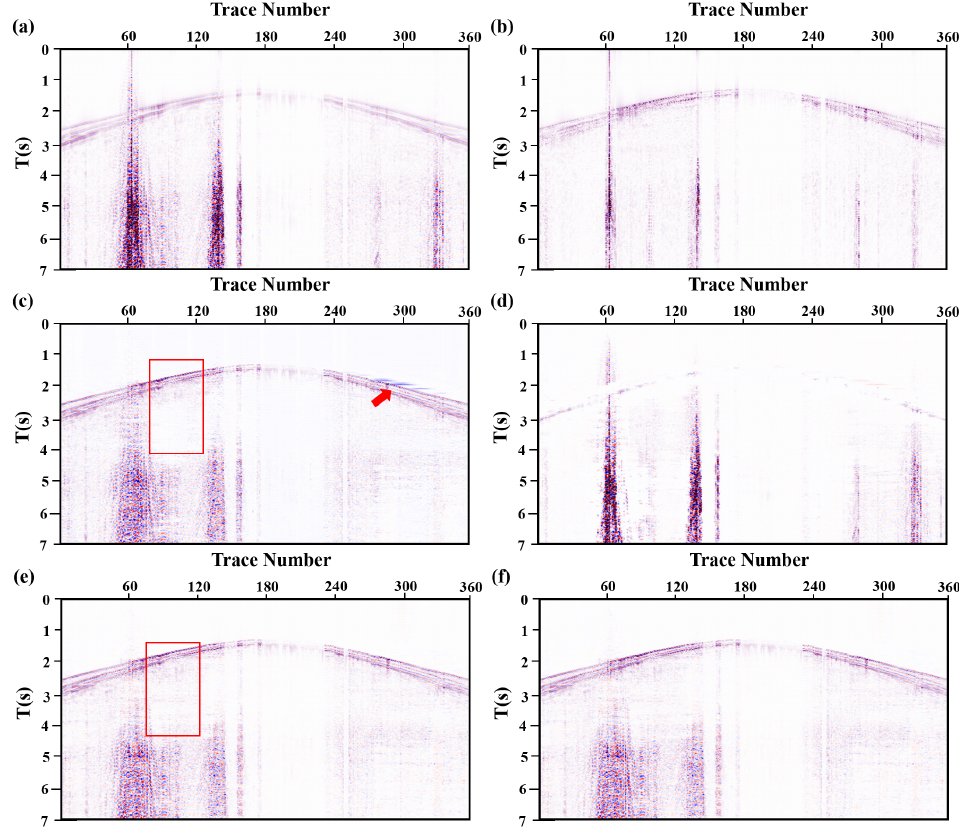
Figure 13. The denoising results and noise sections of different methods for real data: ( a ) The denoising result and ( b ) noise section using f-k filtering; ( c ) the denoising result and ( d ) noise section using the UNet; ( e ) the denoising result and ( f ) noise section using the